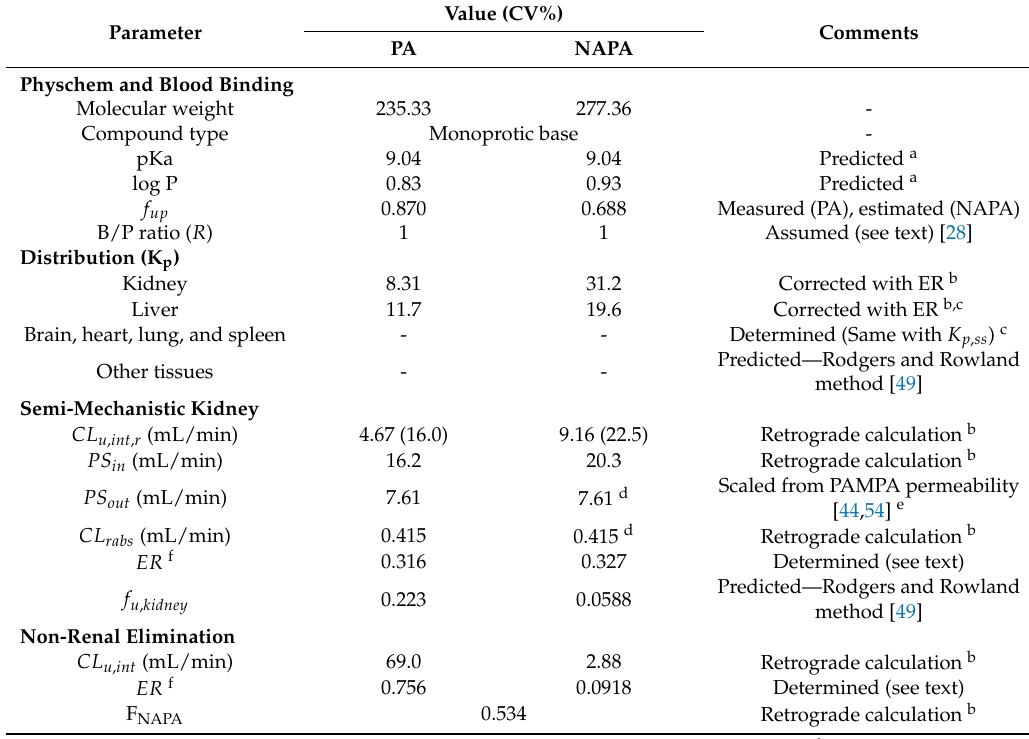
Table 2. Input parameters for PBPK modeling of PA and